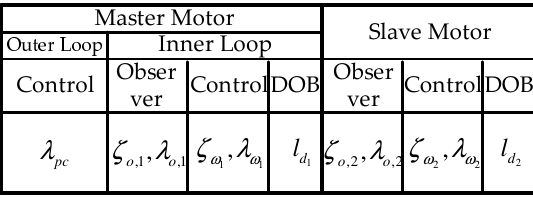
Figure 2. Proposed algorithm with speed synchronizer for output-feedback multi-loop positioning system.